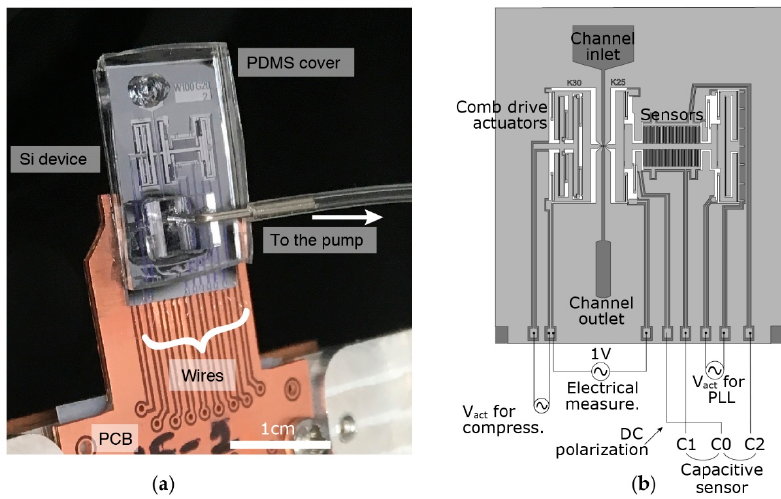
Figure 6. ( a ) An assembled device on printed circuit board (PCB) mounted on the setup, ( b ) Schematic view illustrating electrical connections of a device.